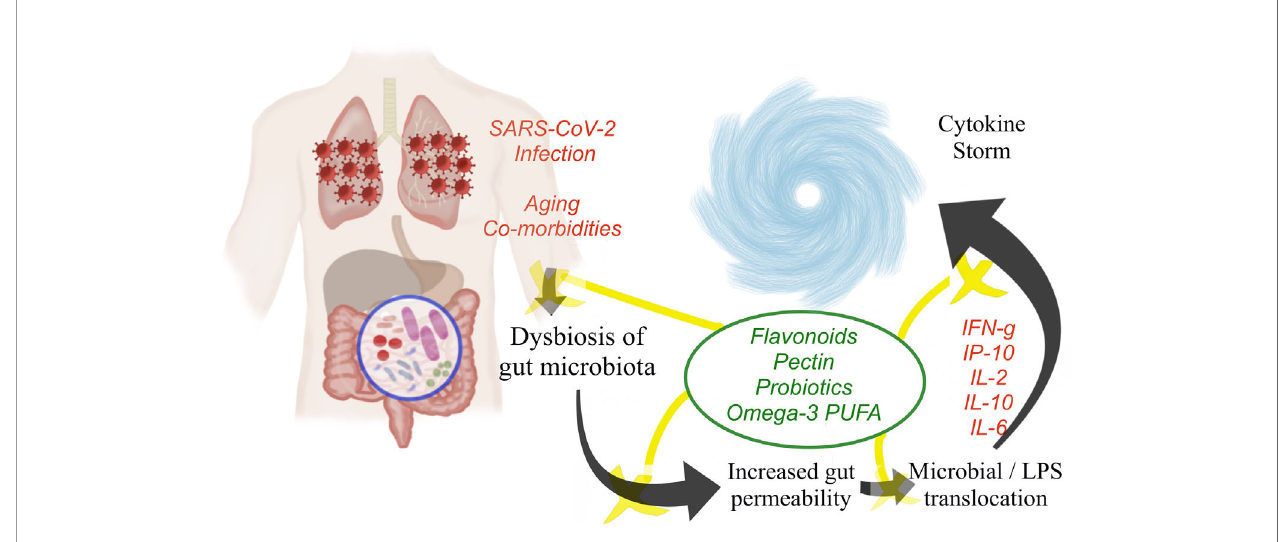
FIGURE 1 | Pathophysiological events of COVID-19 leading to cytokine storm and the potential role of nutraceuticals in attenuating the cytokine